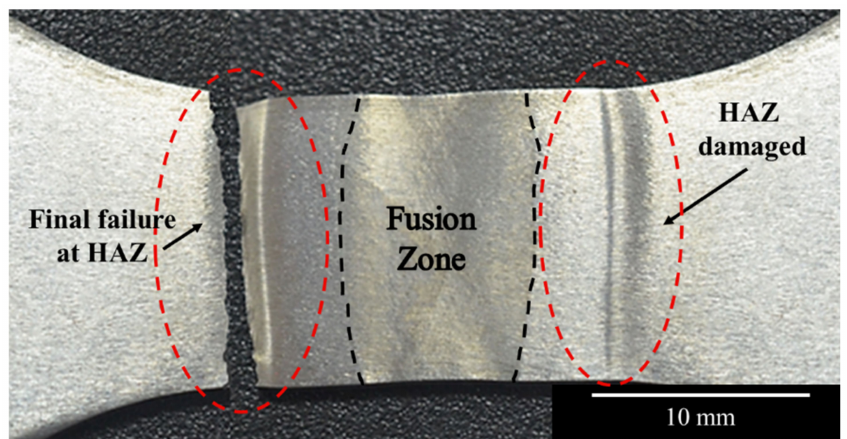
Figure 15. Failure zone of welded joints after LCF tests.